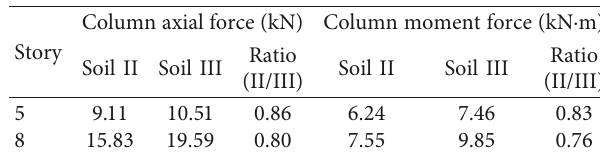
Table 10: Average of maximum column force under near-field